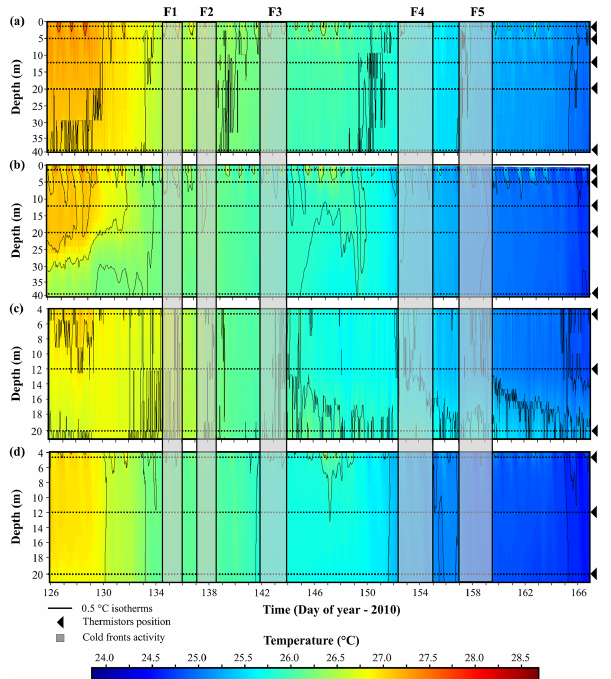
Figure 4. Observed (a) and modeled (b) water column tempera- ture in the region near the dam (station S1), and observed (c) and modeled (d) water column temperature in the transition zone (sta- tion S2).